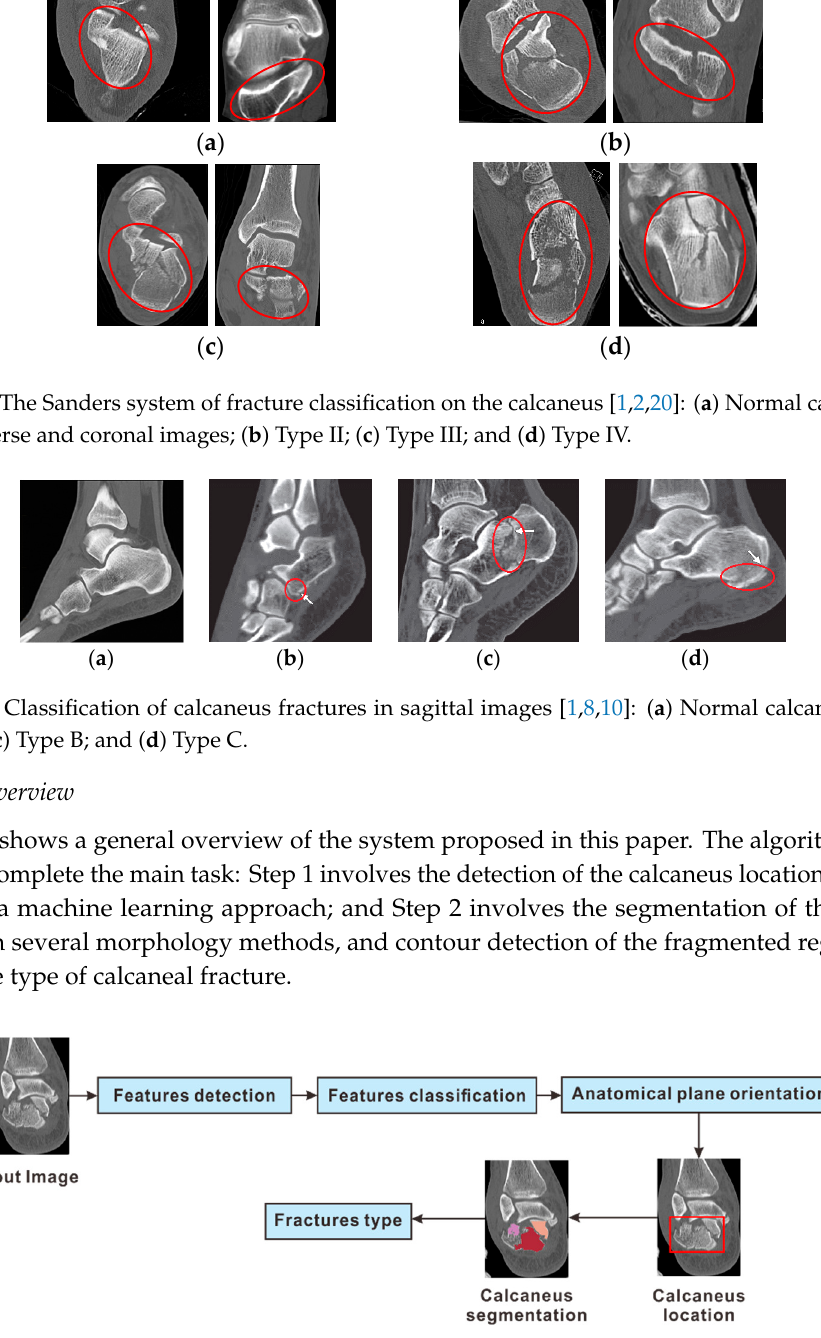
Figure 3. System overview of the proposed method.